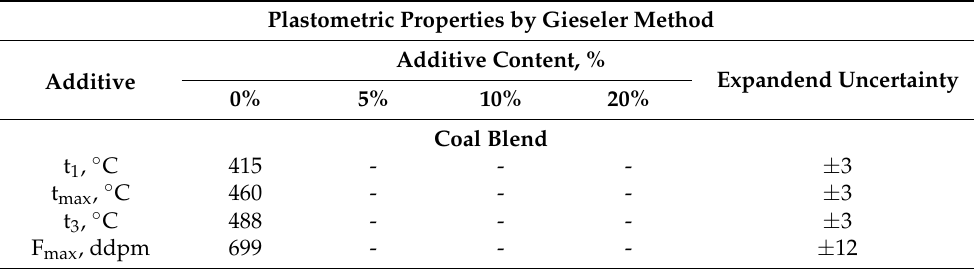
Table A2. The influence of raw biomass supplementation on Gieseler plastometric